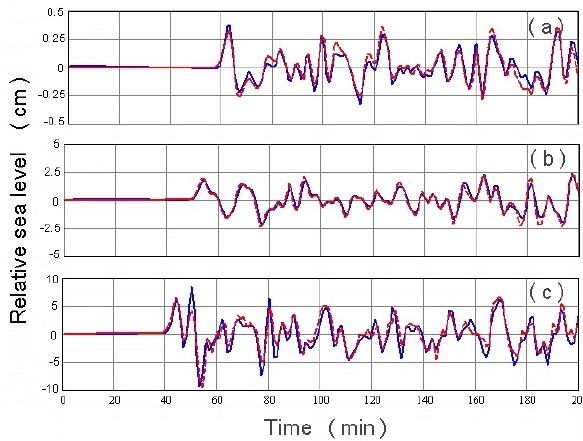
Fig. 2. Illustration of the reciprocity relationships. (a) Waveforms at Site T due to Source 1 (blue solid line) and at Site 1 due to Source T (red dashed line); correlation coefficient ρ 12 = 0.96. (b) Wave- forms at Site 2 due to Source 1 (blue solid line) and at Site 1 due to Source 2 (red dashed line); correlation coefficient ρ 12 = 0.94. (c) Waveforms at Site T due to Source 2 (blue solid) and at Site 2 due to Source T (red dashed line) correlation coefficient ρ 12 =